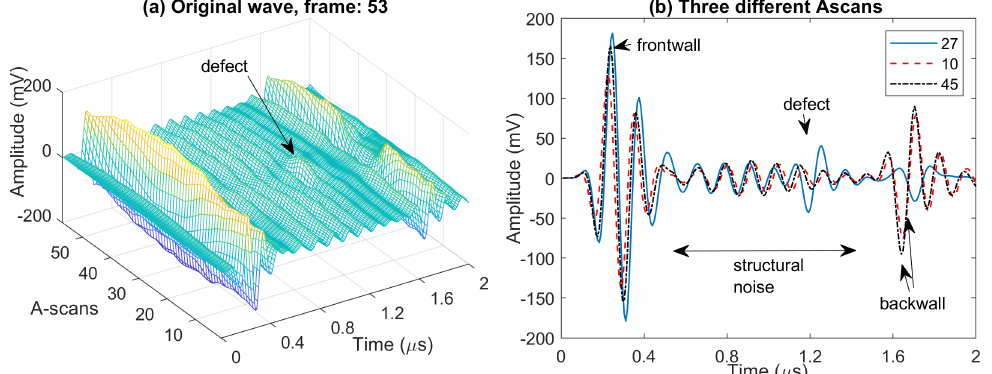
Figure 4. ( a ) 3D plot of full waveform scan data using 10 MHz PA transducers for a frame (one line-scan) having defect echoes, and ( b ) three selected A-scans from this